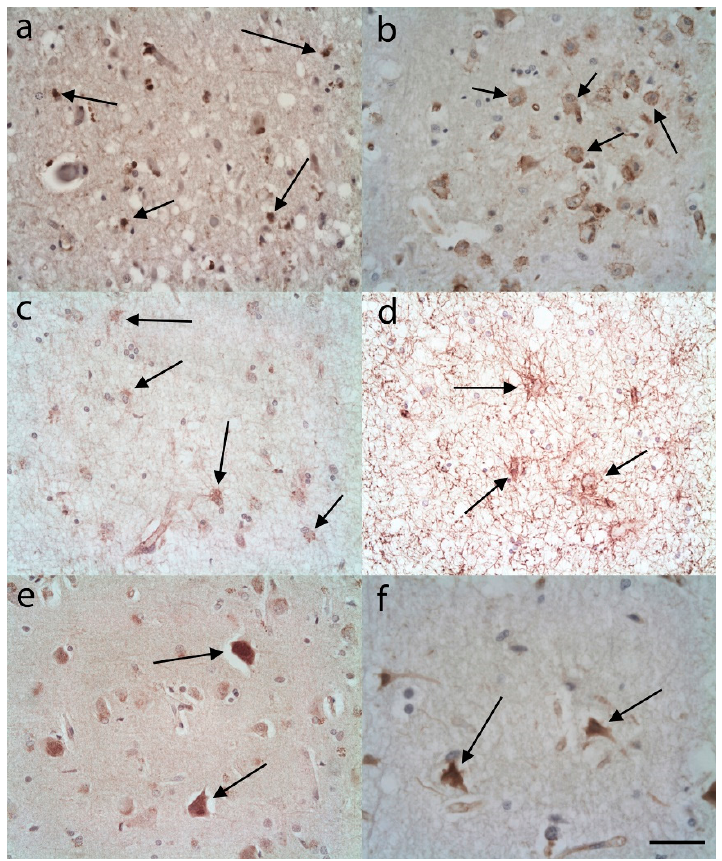
Figure 10. C3 immunohistochemistry ( a ), ( c ), ( e ); and S100A10 immunohistochemistry ( b ), ( d ), ( f ); In acute/recent cerebral infarcts ( a ) and ( b ) there were C3 immunopositive cells many of which appeared to be ASLCs ( a , arrows). There were also a number of S100A10 immunopositive cells some of which appeared to be ASLCs, but some, as shown here, appeared to be neurons ( b , arrows). In old cerebral infarcts ( c ) and ( d ) there were occasional weakly staining C3 immunopositive ASCLs ( c , arrows) some of which were star shaped. There were more intensely stained S100A10 immunopositive ASLCs seen in the old infarcts ( d , arrows). With C3 immunohistochemistry ( e ) and S100A10 immunohistochemistry ( f ) there was occasional neuronal immunopositivity distant from the main focus of infarction (arrows). Anti-C3 ( a ), ( c ), ( e ); Anti-S100A10 ( b ), ( d ), ( f ). Original magnifications ( a )–( d ) × 40 (NA 0.9), ( e ), ( f ) × 60 (NA 0.9). Scale Bar ( a )–( d ) − 60 µm, ( e ), ( f ) –50